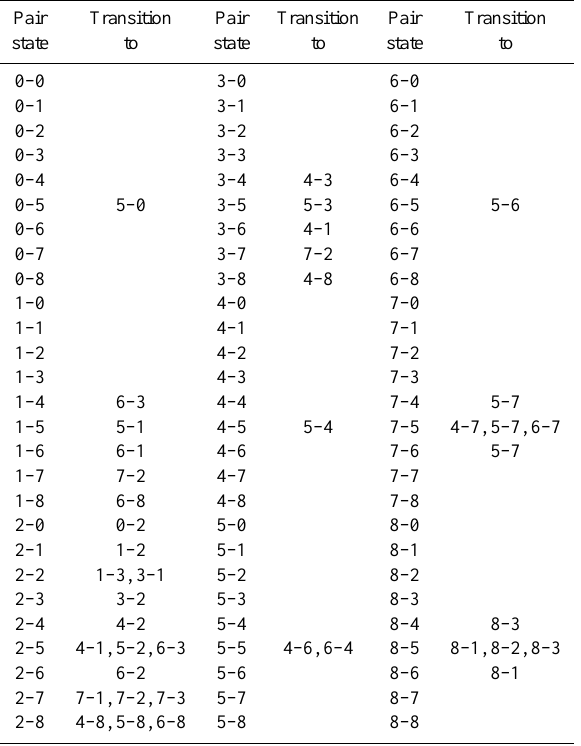
Table 2. Transitions for orientation 1 in the CTS Lattice Gas model. Node states are as defined in Table 1. First number of each pair is lower-left and second is upper-right. Pairs with three possible transi- tions have a rate of one-third each; pair with two possible transitions has rate of one-quarter (representing rear collision).